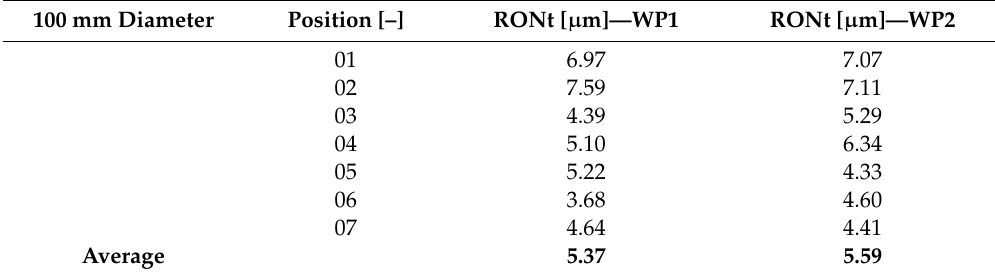
Table 13. RONt results [µm]—100 mm diameter.